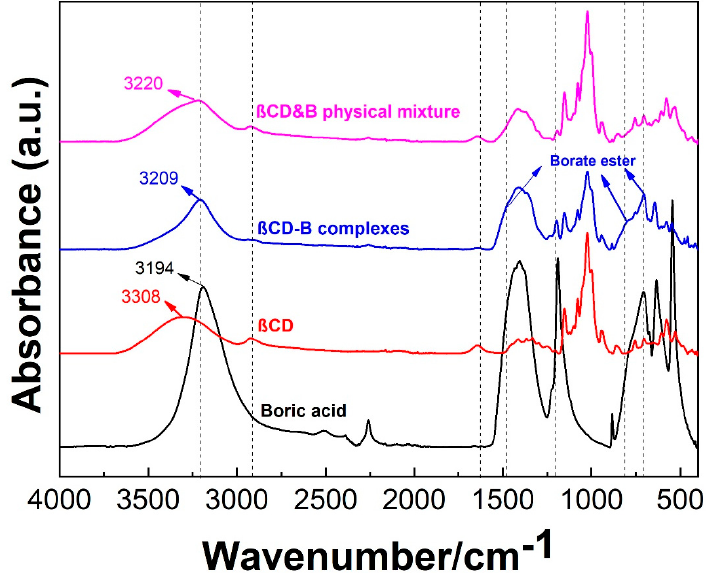
Figure 3. Infrared spectra of boric acid, β CD, β CD–B complex and their physical mixture.